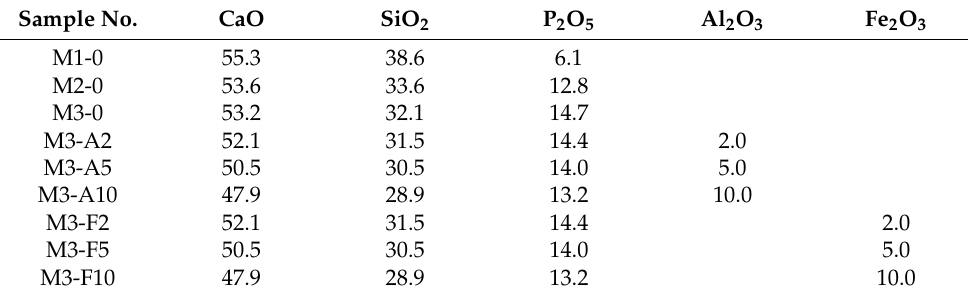
Table 2. Composition of the samples employed (in mass%). Sample